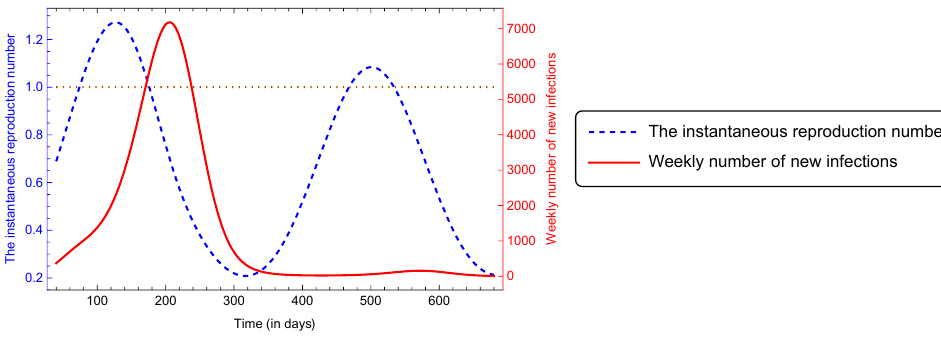
as a function of B and one of the three controllable parameters: 0 v ) and human-to-mosquito transmission rate ( α h